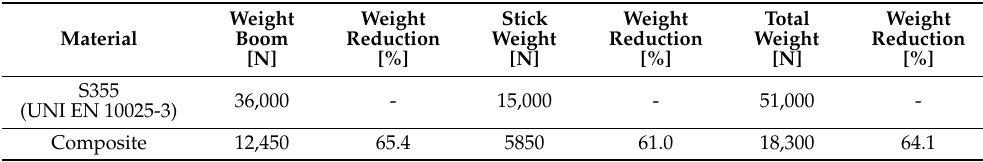
Table 3. Weight reduction using composite